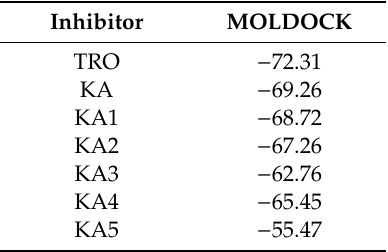
TRO: Tropolone; KA: Kojic acid.